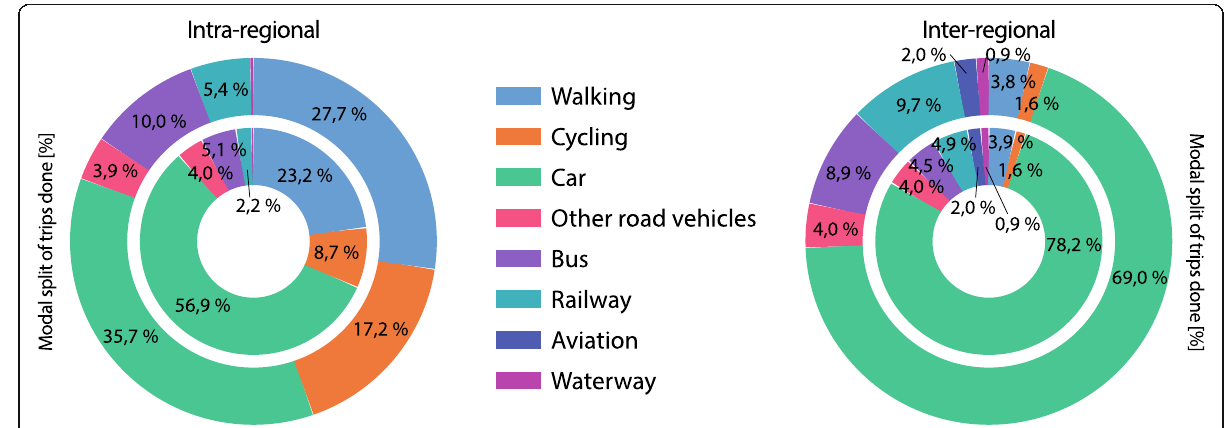
Fig. 3 Modal split in intra- and inter-regional travel in reference and technology scenarios (inner circle) and recommendation scenario (outer circle) in 2050. Modal splits in Figure 3 present the share of trips done with different modes of transport in 2050 according to the different scenarios in this study. Intra-regional travel refers to urban mobility and inter-regional to intercity and long-distance